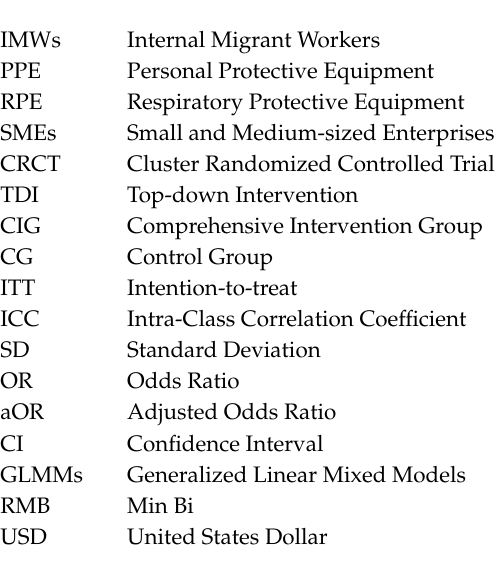
Table S1: Questions for measuring secondary outcomes, Table S2: Baseline characteristics of the 60 study SMEs in intervention and the control